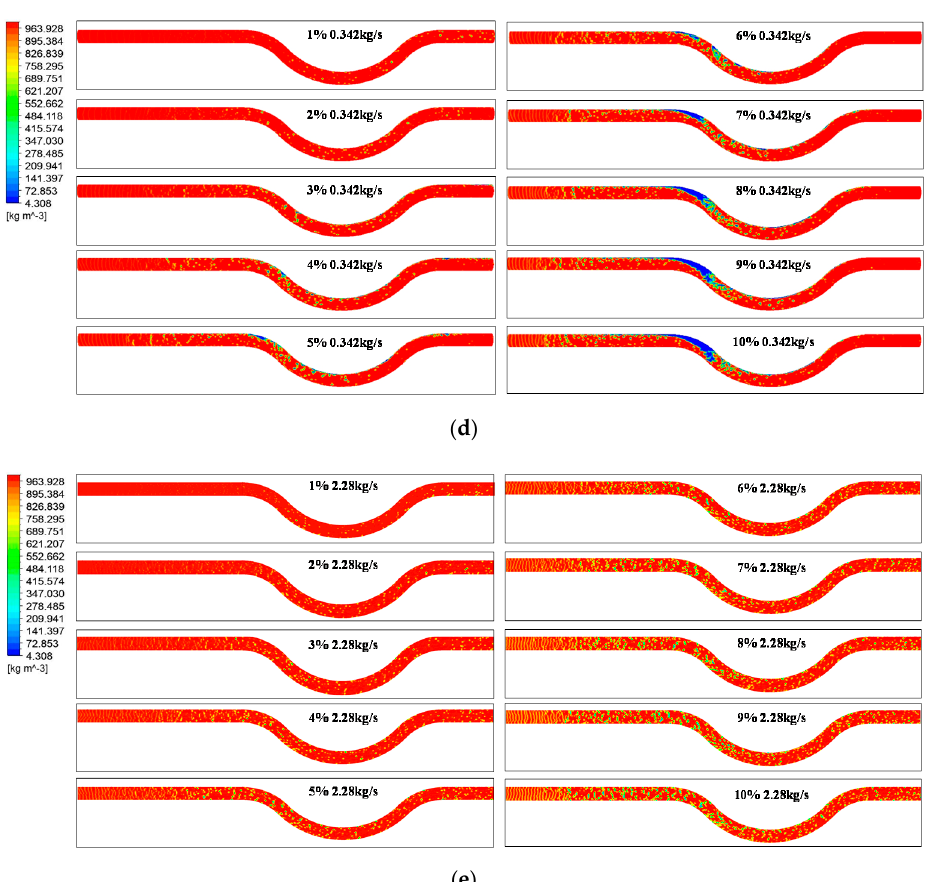
Figure 3. The flow patterns in different total mass flows and Gas Volume Fractions (GVFs); (a) The flow patterns in different Gas Volume Fractions (GVFs) with total mass flow 0.0912 kg/s; (b) The flow patterns in different Gas Volume Fractions (GVFs) with total mass flow 0.1368 kg/s; (c) The flow patterns in different Gas Volume Fractions (GVFs) with total mass flow 0.2280 kg/s.; (d) The flow patterns in different Gas Volume Fractions (GVFs) with total mass flow 0.3420 kg/s; (e) The flow patterns in different Gas Volume Fractions (GVFs) with total mass flow 2.280 kg/s.